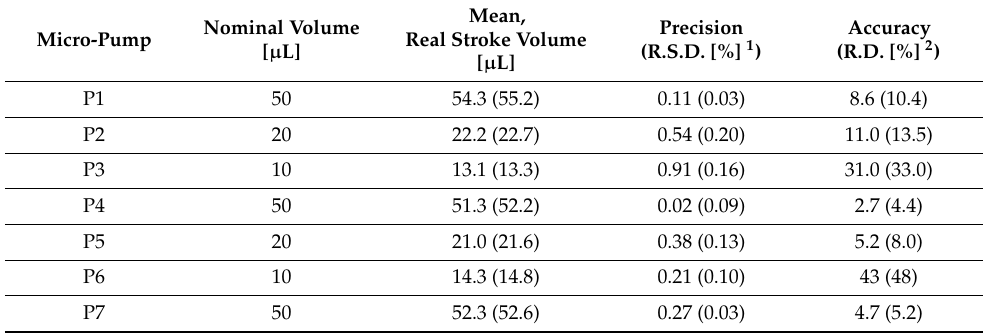
Table 1. Results of the re-calibration of the